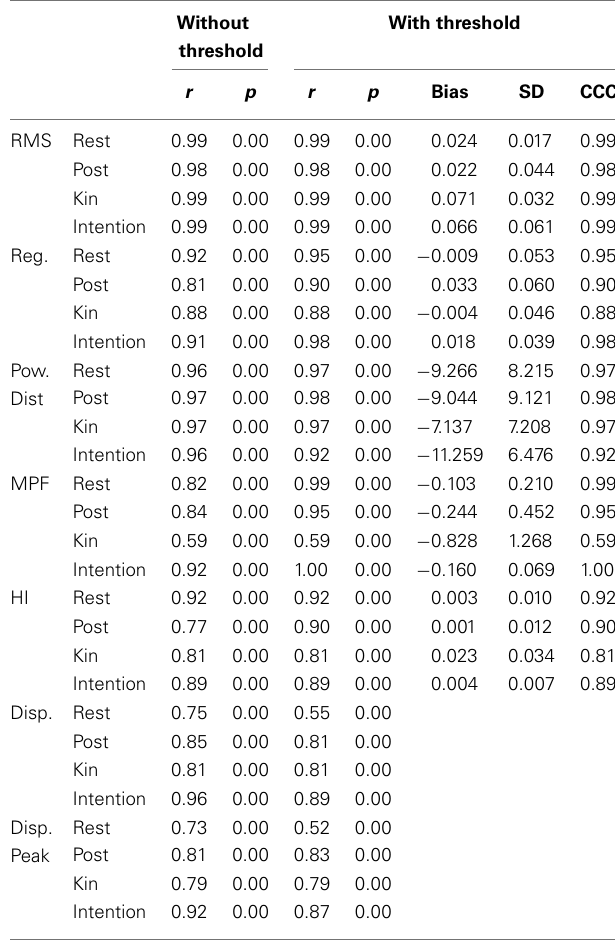
Table 1 | Correlation coefficients between the results obtained from the algorithms imbedded within the smart phone and the results obtained from the analysis of the time series from the smart phone by our analysis package using the S-Plus software.